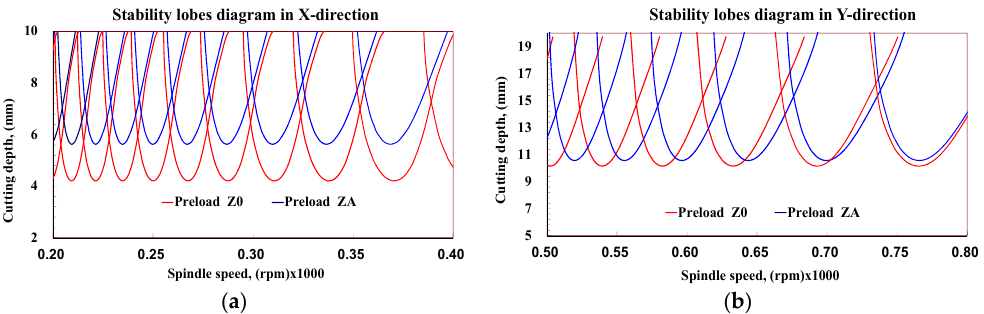
Figure 12. Comparisons of the stability lobe diagram predicted at the vibration mode associated with machine tool structure with different preloaded guideways. ( a ) Stability lobes in X direction, ( b ) Stability lobes in Y